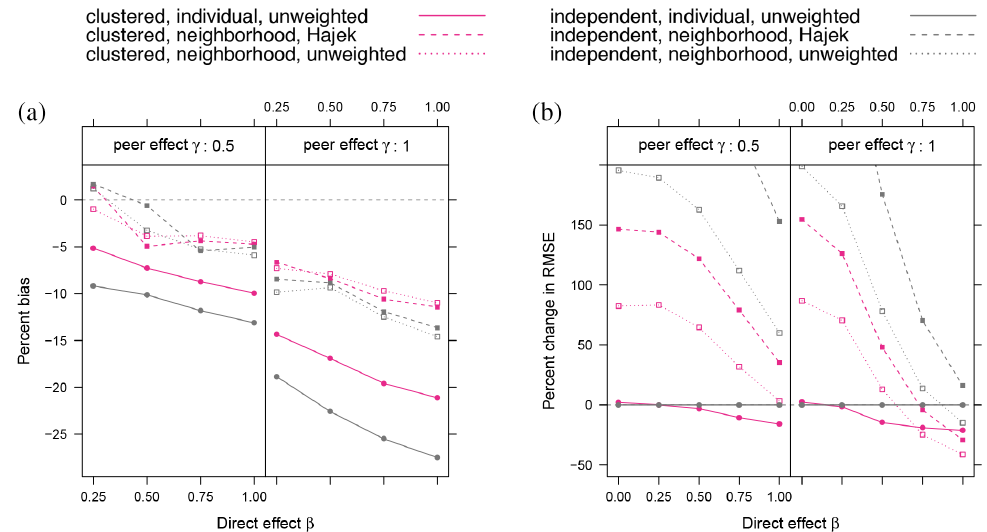
Figure 8 Relative bias (a) and change in RMSE (b) in ATE estimates for different assignment procedures, exposure mod- els, and estimation method, using the degree-corrected block model with community proportion u using the exposure model provides additional bias reduction over using graph cluster randomization only – with a cost in